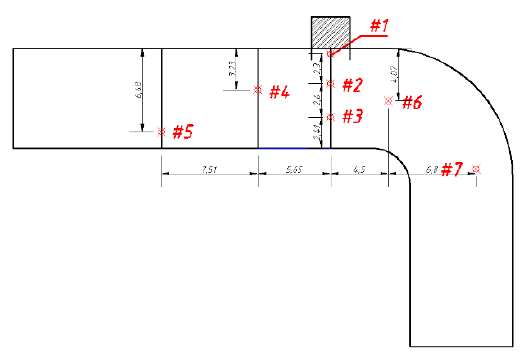
Figure 1. Model of the river section.